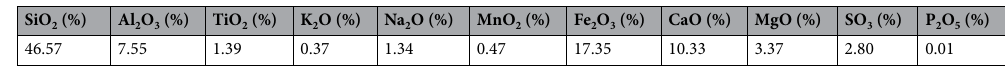
Table 2. Oxides in the ash residue of the coal